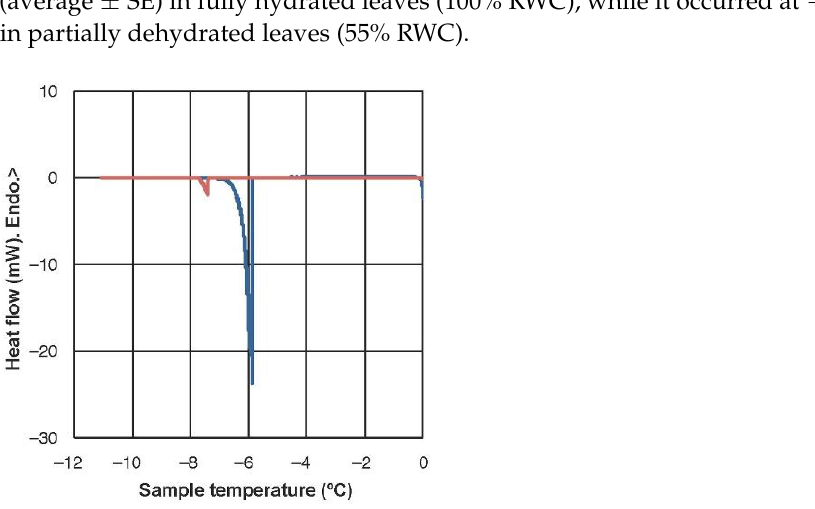
Figure 2. A differential scanning calorimetry (DSC) scan of a hydrated and of a partially dehydrated (RWC = 55%) leaf of Haberlea rhodopensis . The scan was recorded at a cooling rate of 0.05 °C min −1 . One representative scan is shown for each hydration level (blue: hydrated samples, red: dehydrated samples). The average ice nucleation temperature was −5 .81 ± 0.30 and −6 .62 ± 0.06 °C for leaves at 100% and at 55% of RWC, respectively. Water content was 4.1 ± 0.2 g H 2 O g −1 DW and 2.8 ± 0.1 g H 2 O g −1 DW for leaves at 100% and 55% of RWC, respectively (average ± SE, n = 7).